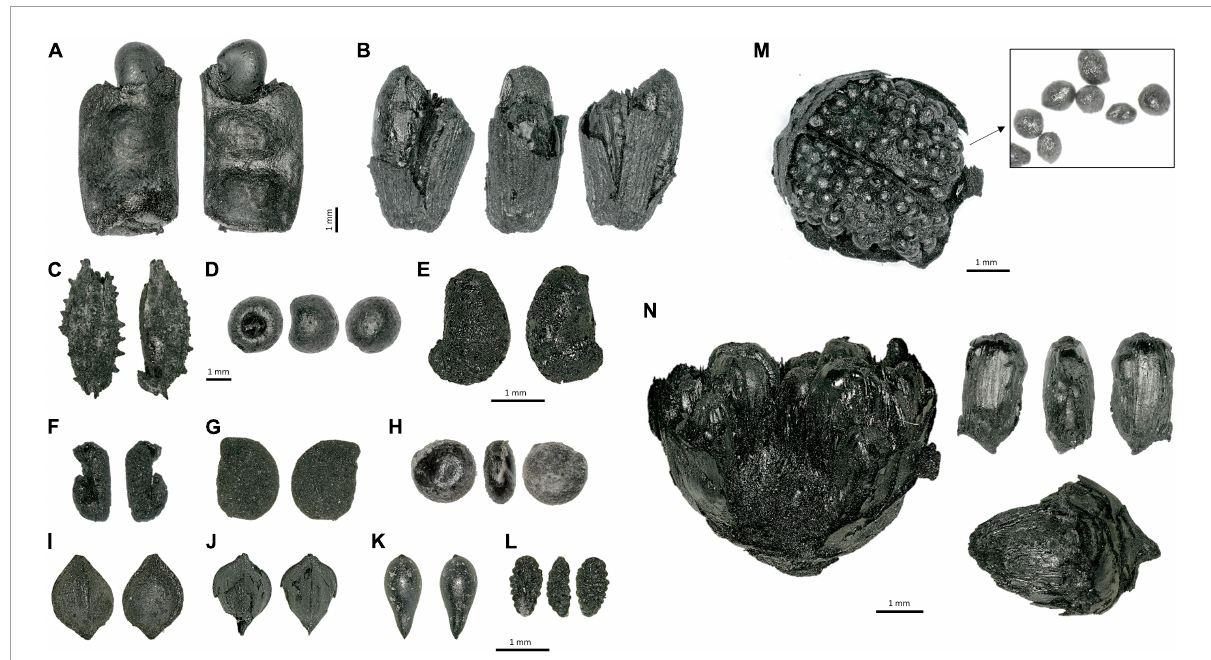
FIGURE8 Selection of wild seeds present in the assemblage: (A) Alhagi sp. seed and pod, (B) Aegilops sp. spikelet, (C) Xanthium fruit, (D) Galium , (E) Medicago/Melilotus , (F) Trigonella , (G) Potentilla/Fragaria , (H) Chenopodium , (I) Cyperaceae, (J) Rumex , (K) Thymelaea , (L) Veronica , (M) unknown fruit with close up of seeds, and (N) Asteraceae floral buds with involucral